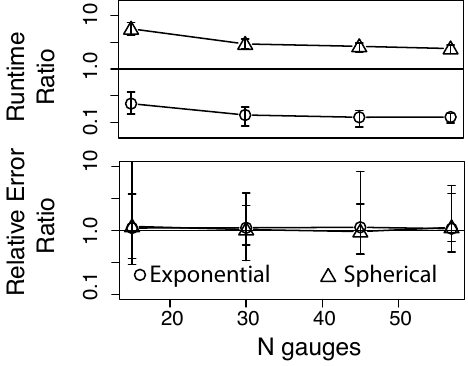
Figure 10. Leave-one-out cross-validation results for Austrian sum- mer flow when resampling a subset of the training gauges. Compu- tational performances are represented as the ratio of runtimes for TopREML against Top-kriging. Prediction performances are rep- resented as the ratio of relative errors. TopREML performances when using gradient-based and stochastic optimization algorithms are represented as circles and triangles, respectively. Points repre- sent the median value and error bars represent 90% confidence in- tervals over 200